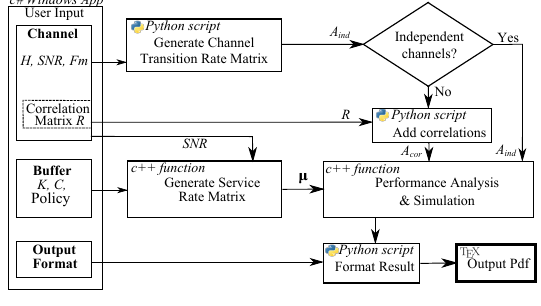
Figure 2: Structure of the performance evaluation